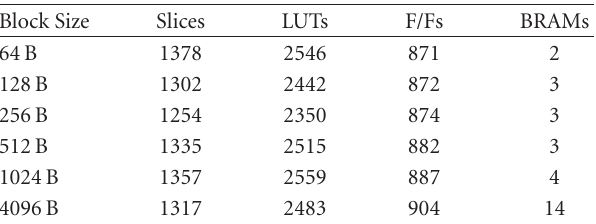
Table 3: Hardware filesystem with multiple disk resource utiliza- tion with Block Size 1024 synthesized for the